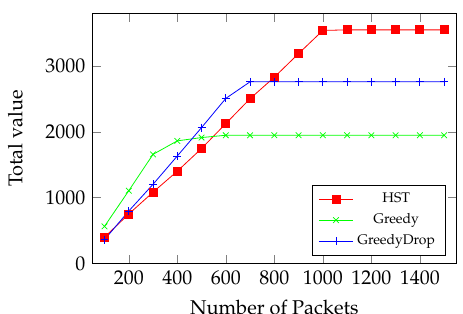
Figure 10. Comparison between HST, Greedy and GreedyDrop when running over non-FIFO tasks.